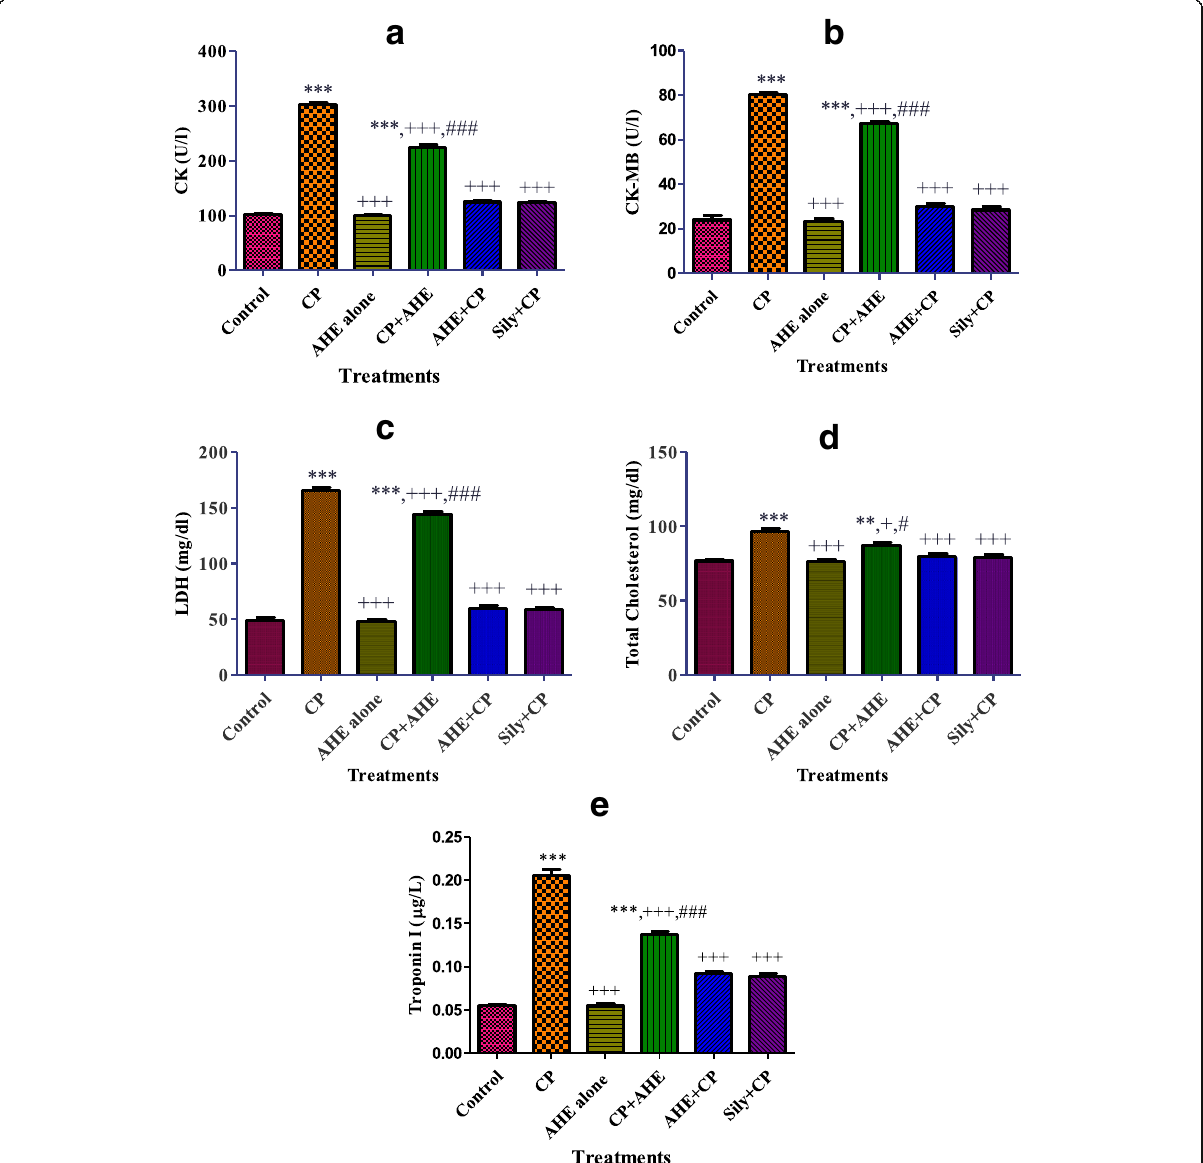
Fig. 1 Effect of AHE treatment on serum markers of cardiac injury. a : CK, b : CK-MB, c : LDH, d : cholesterol and e : Troponin I. Data are represented mean ± S.E.M ( n = 6). Asterisks *, **, *** indicates p < 0.05, 0.001, 0.0001 vs. control; +, ++, +++ indicates p < 0.05, 0.001, 0.0001 vs. CP; #, ##, ### indicates p < 0.05, 0.001, 0.0001 vs. AHE+